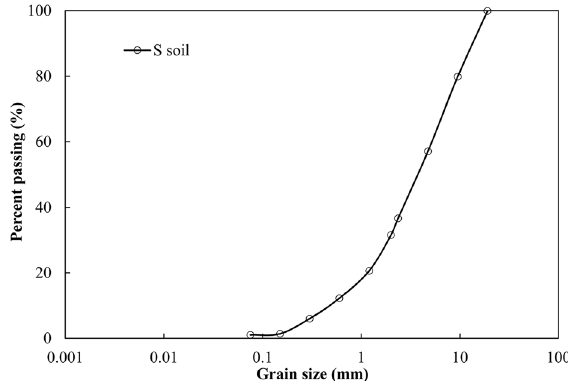
Fig. 1 The grains size distribution of native soils (S